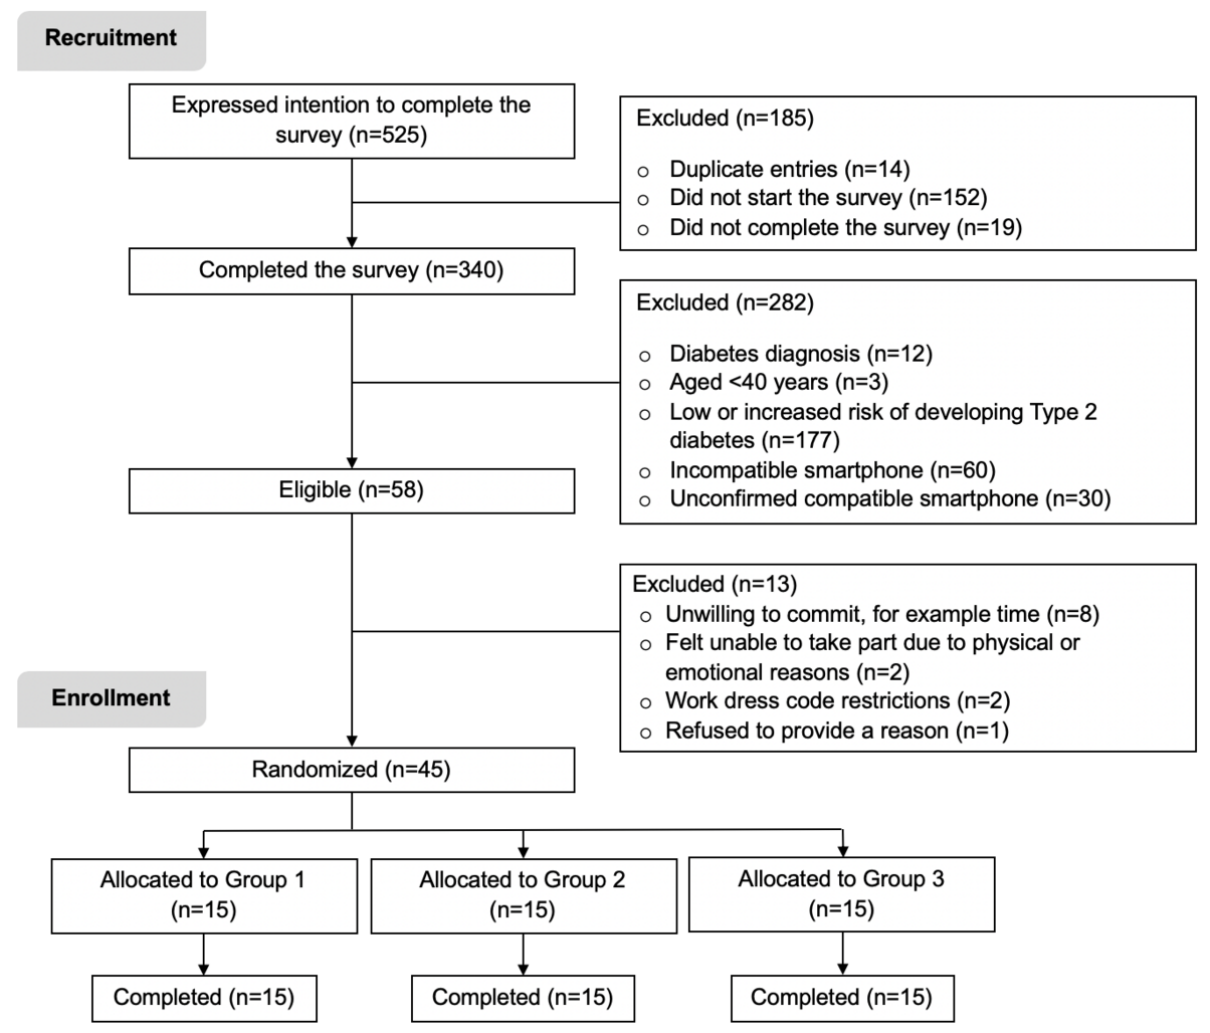
Figure 2. A flow chart of participant recruitment, enrollment and allocation for the